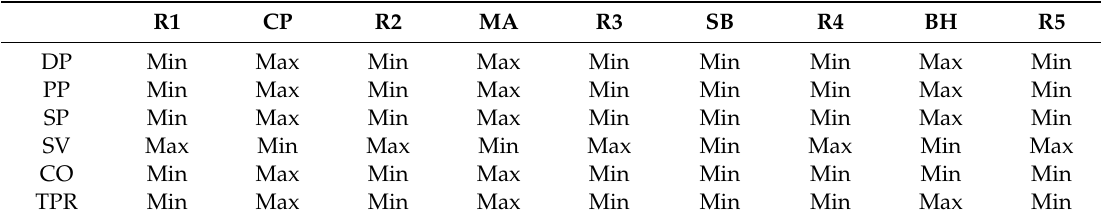
Table 2. Extremum regions of cardiovascular (CV) parameters in individual rest and intervention